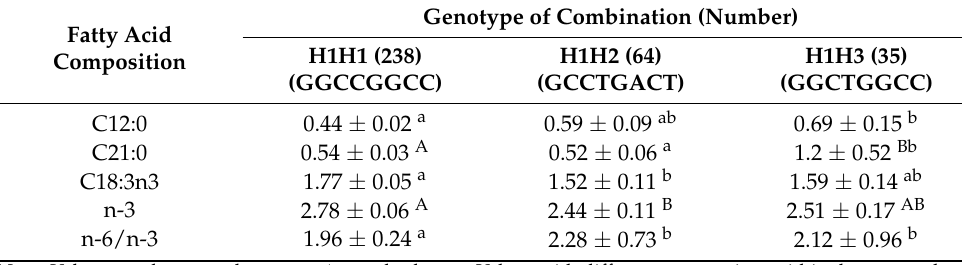
Table 5. Associations between haplotypes of CAST and fatty acid composition in the longissimus thoracis muscle of Sonid sheep.